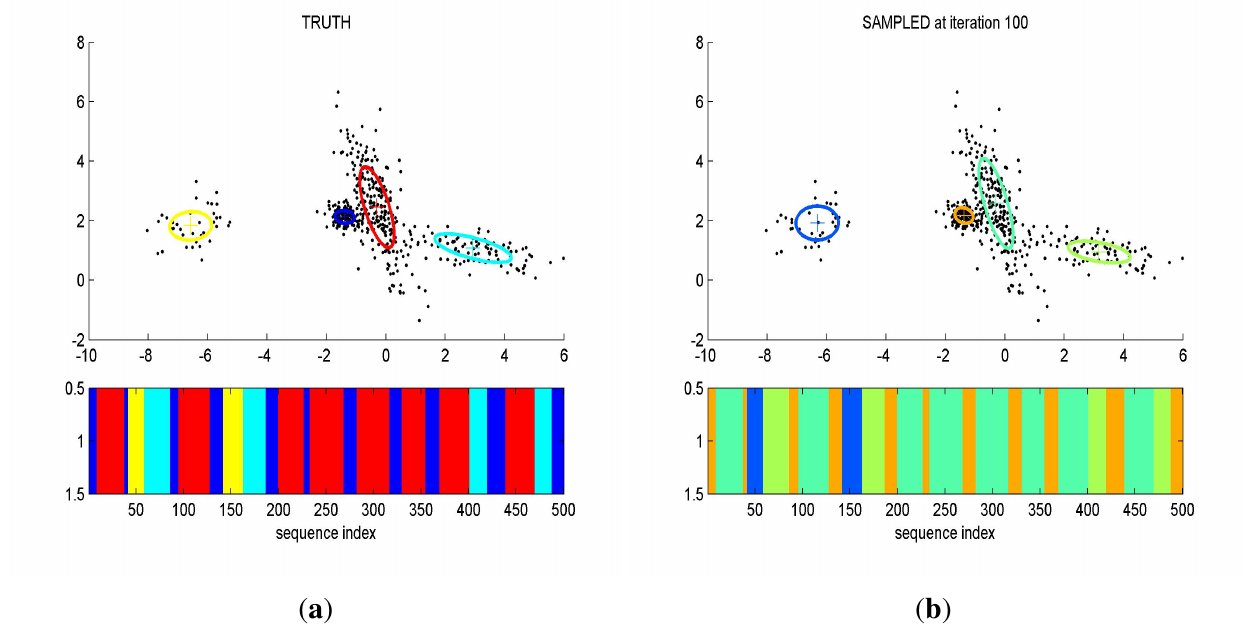
Figure 6. ( a ) Data generated from the true model; ( b ) Model Learned from the data using HDP-HSMM: Reproduced results from